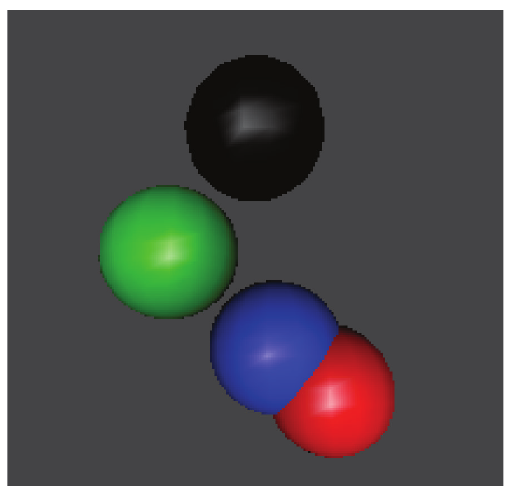
Figure 8: Results of bootstrapped PCA examining di ff erences between real data and simulated data. Black = real visitor data, red = real ethogram data, green = simulated visitor data where data were collected for 8 min, and blue = simulated visitor data where data were collected for 30s. Cumulative proportion of variance explained by first 3 principal components =